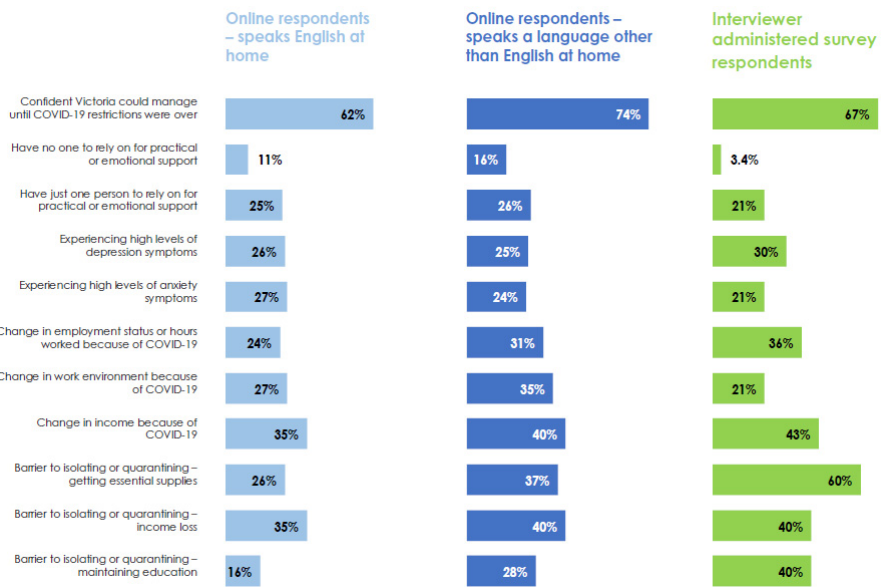
Figure 2. Comparison of CARE responses for different participant groups, Victoria, September–October 2020.Discussion.